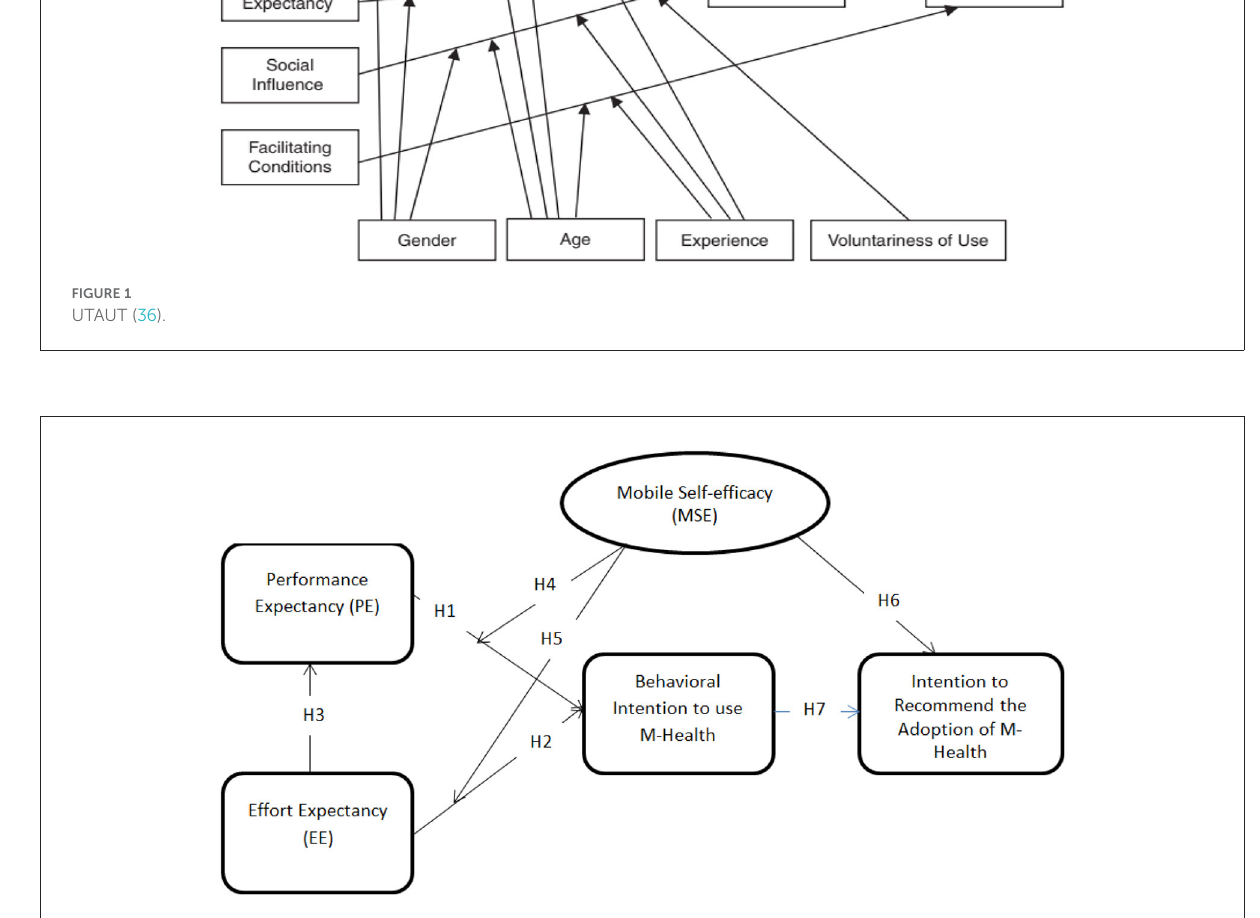
FIGURE2 Proposed research